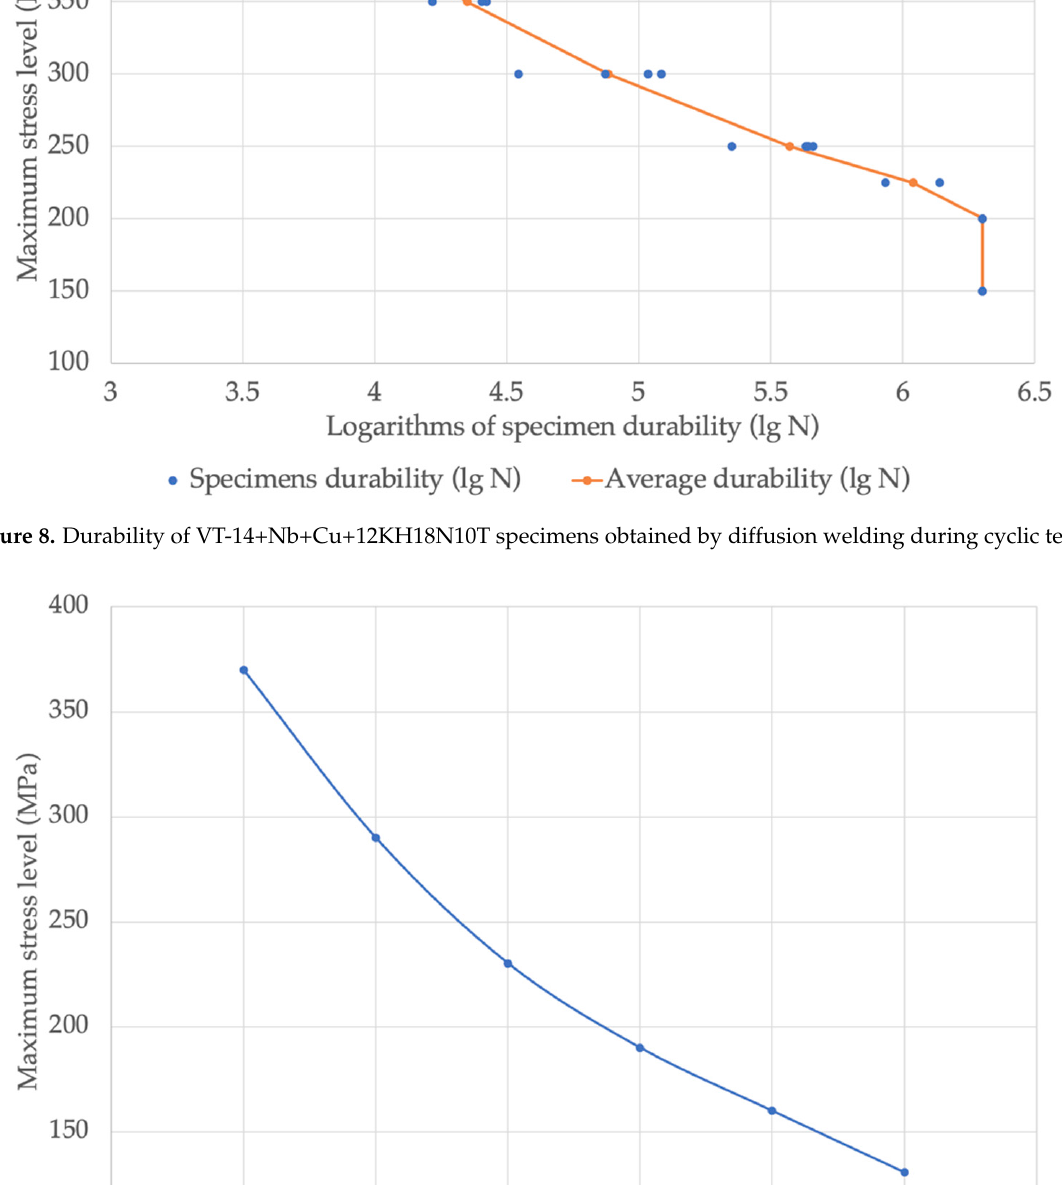
Table 13. Impact strength test results.